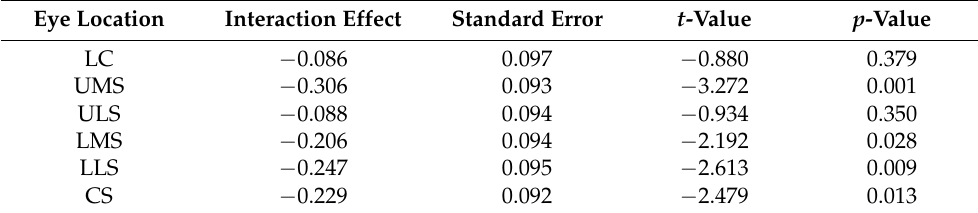
Figure 4. Boxplot of temperature change at the seven locations across the eye after racing. Both before and after racing the medial canthus had the highest temperature, followed by the lateral canthus. Table 5. Estimates of interaction effect, standard error, t -value and p -value of post-racing temperature at different anatomical locations across the eye compared to the medial canthus.